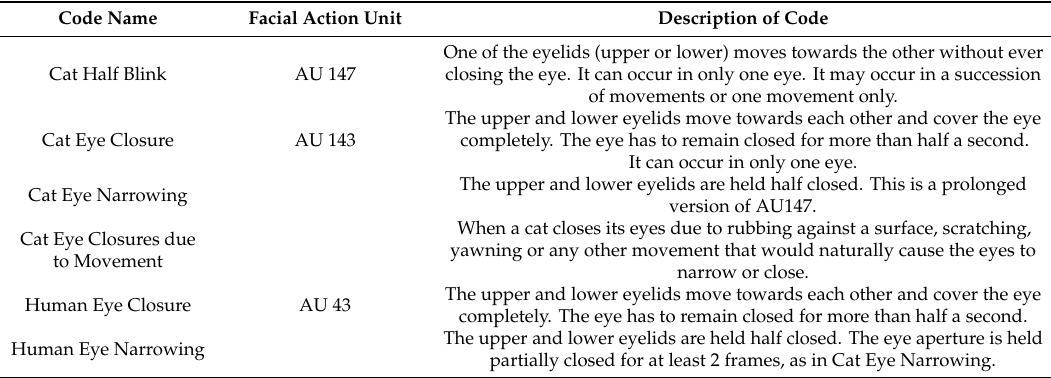
Table 1. Cat and human eye movements and corresponding facial action units (AU; Facial Action Coding System). See [24,25] for descriptions and photographs of the actions